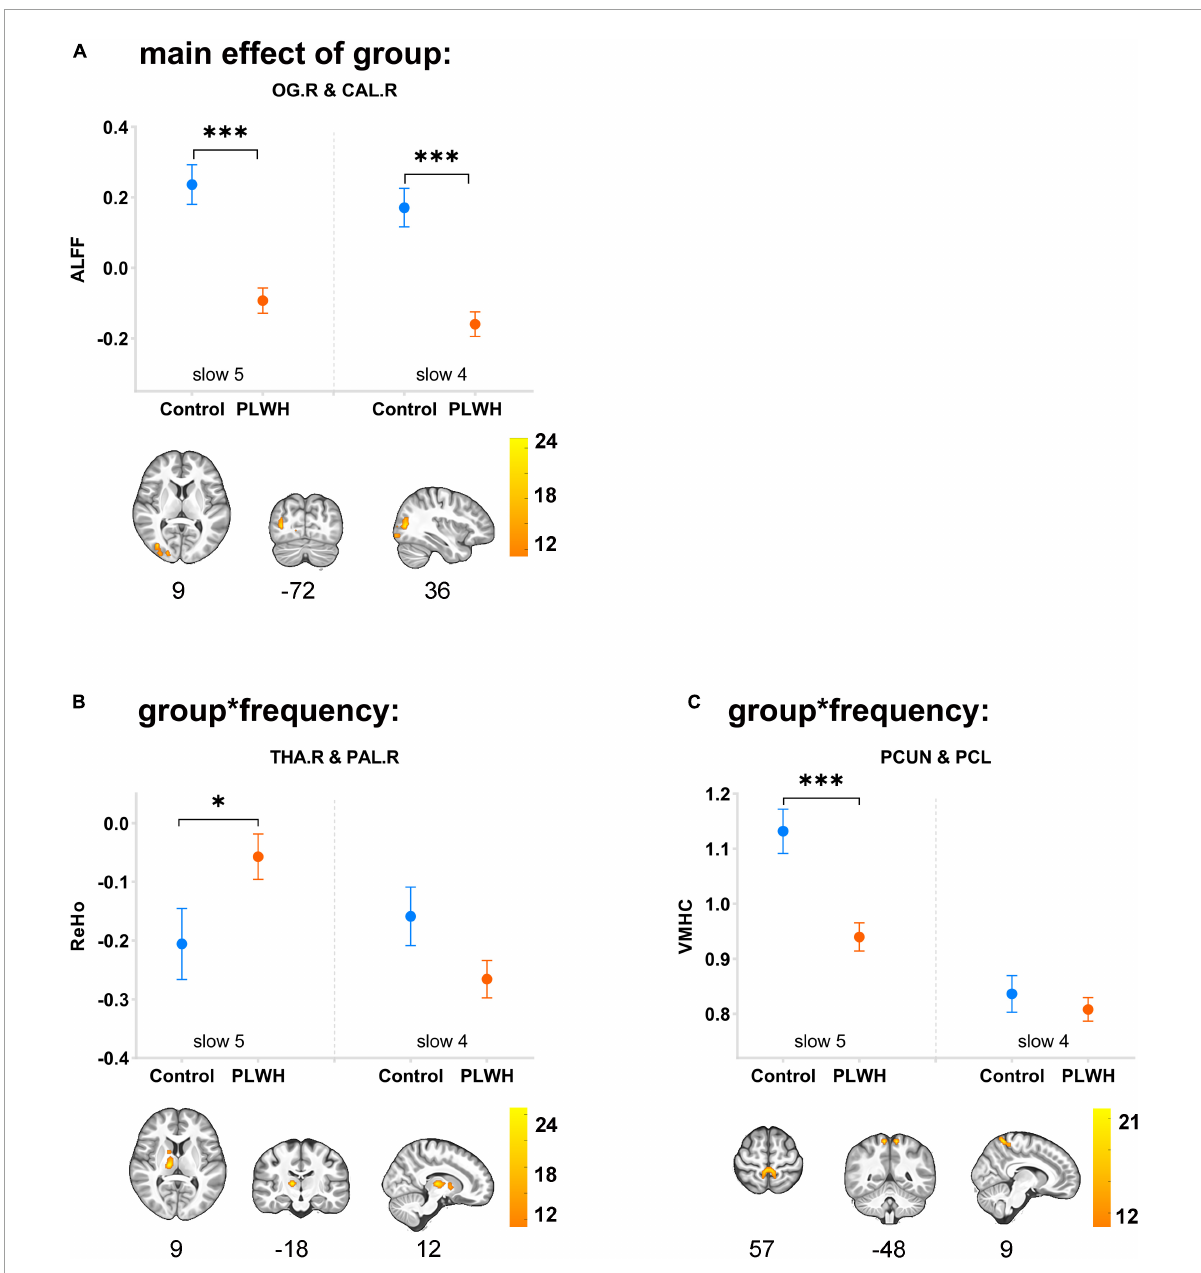
FIGURE1 Main effects of group and group-by-frequency interaction in PLWH are compared with seronegative controls. The main effect of group was detected in ALFF (A) , with differences located in the OG.R and CAL.R; group-by-frequency interactions were detected in the THA.R and PAL.R for ReHo (B) and bilateral PCUN and PCL for VMHC (C) . Brain regions showing the main effect of group or group-by-frequency interaction were colored by F-statistic (red/yellow). The upper row graph displayed the differences (mean ± SEM) between groups in slow-5 (plotted on the left side of the separatrix line) and slow-4 (plotted on the right side). ∗∗∗ P < 0.001; ∗ P < 0.05. Corrected for multiple comparisons ( P < 0.001, corrected at cluster level with FWE P < 0.05). OG.R, right superior/middle/inferior occipital gyrus; CAL.R, right calcarine; THA.R, right thalamus; PAL.R, right globus pallidus; PCUN, precuneus; PCL, paracentral lobe; control, seronegative controls; PLWH, people living with HIV.